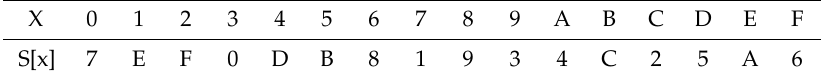
Table 2. Proposed S-box.